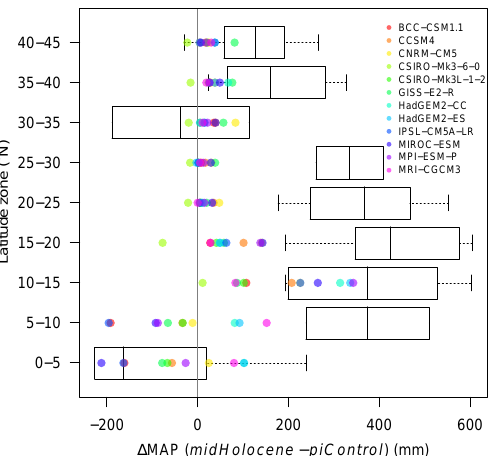
Fig. 6. Comparison of simulated and reconstructed changes in mean annual precipitation in the mid-Holocene for 5 ◦ latitude bands be- tween 0 and 45 ◦ N. The reconstructions are from the Bartlein et al. (2011) data set. The mean, 25–75% range and full range of the reconstructions are shown (for those latitude bands with sufficient data points). The model results are averages for the grid cells with